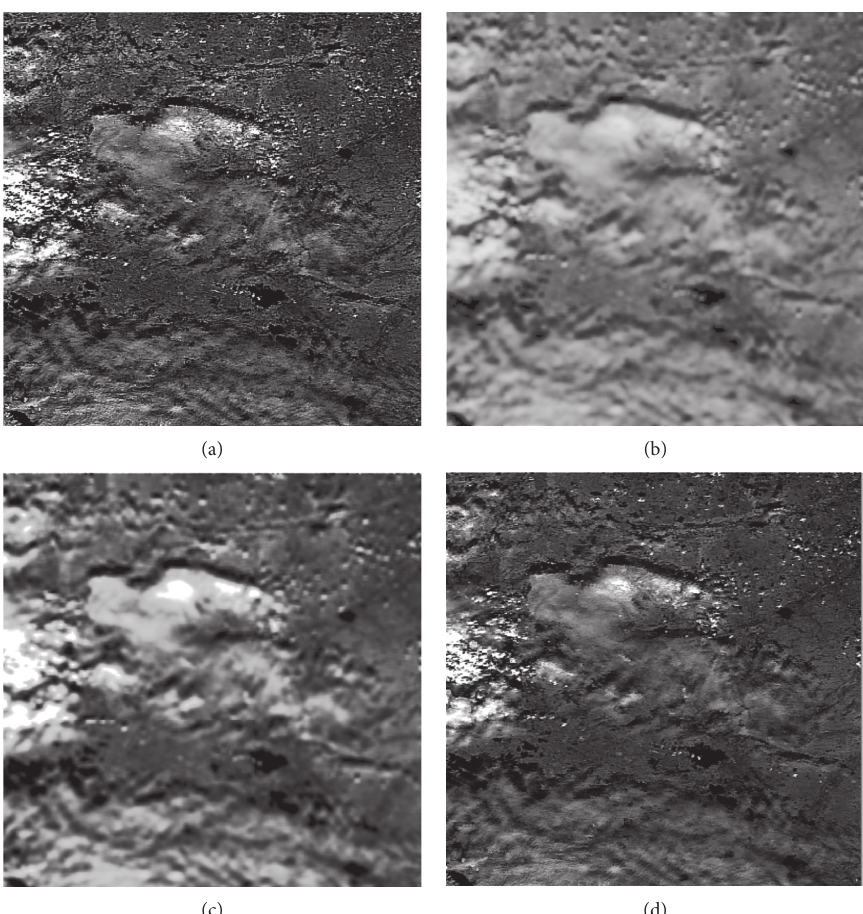
Figure 6: The comparison of the reconstructed effect of the 72rd reference band. (a) Original. (b) MT-Bayes. (c) GPSR. (d) Proposed